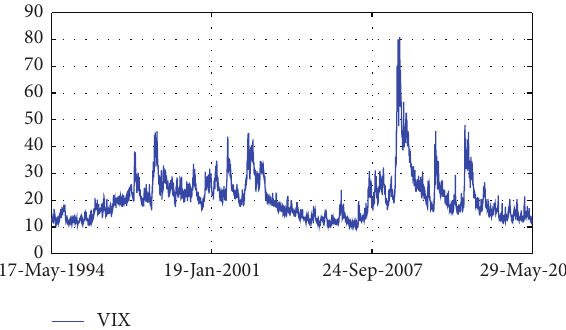
Figure 5: CBOE volatility index (VIX), daily data from 1994 to 2014.